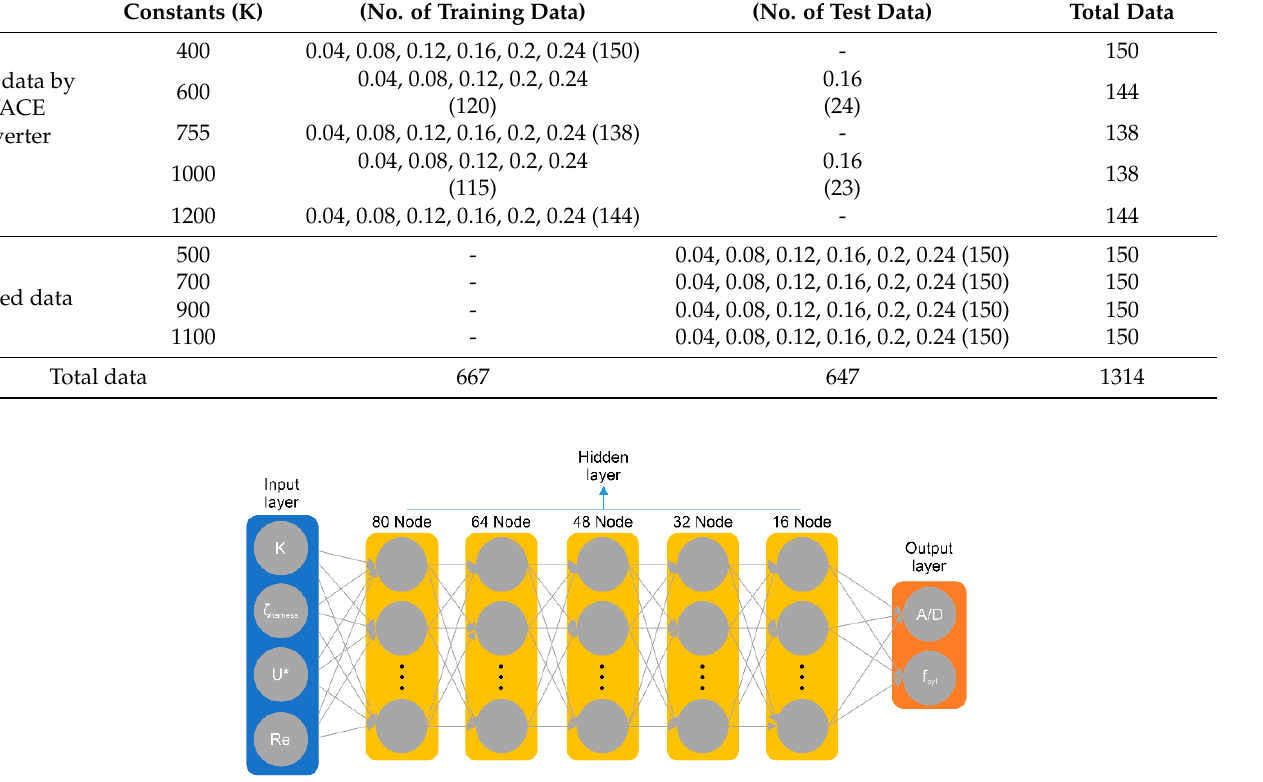
Figure 8. Structure of the deep neural network used in this study.